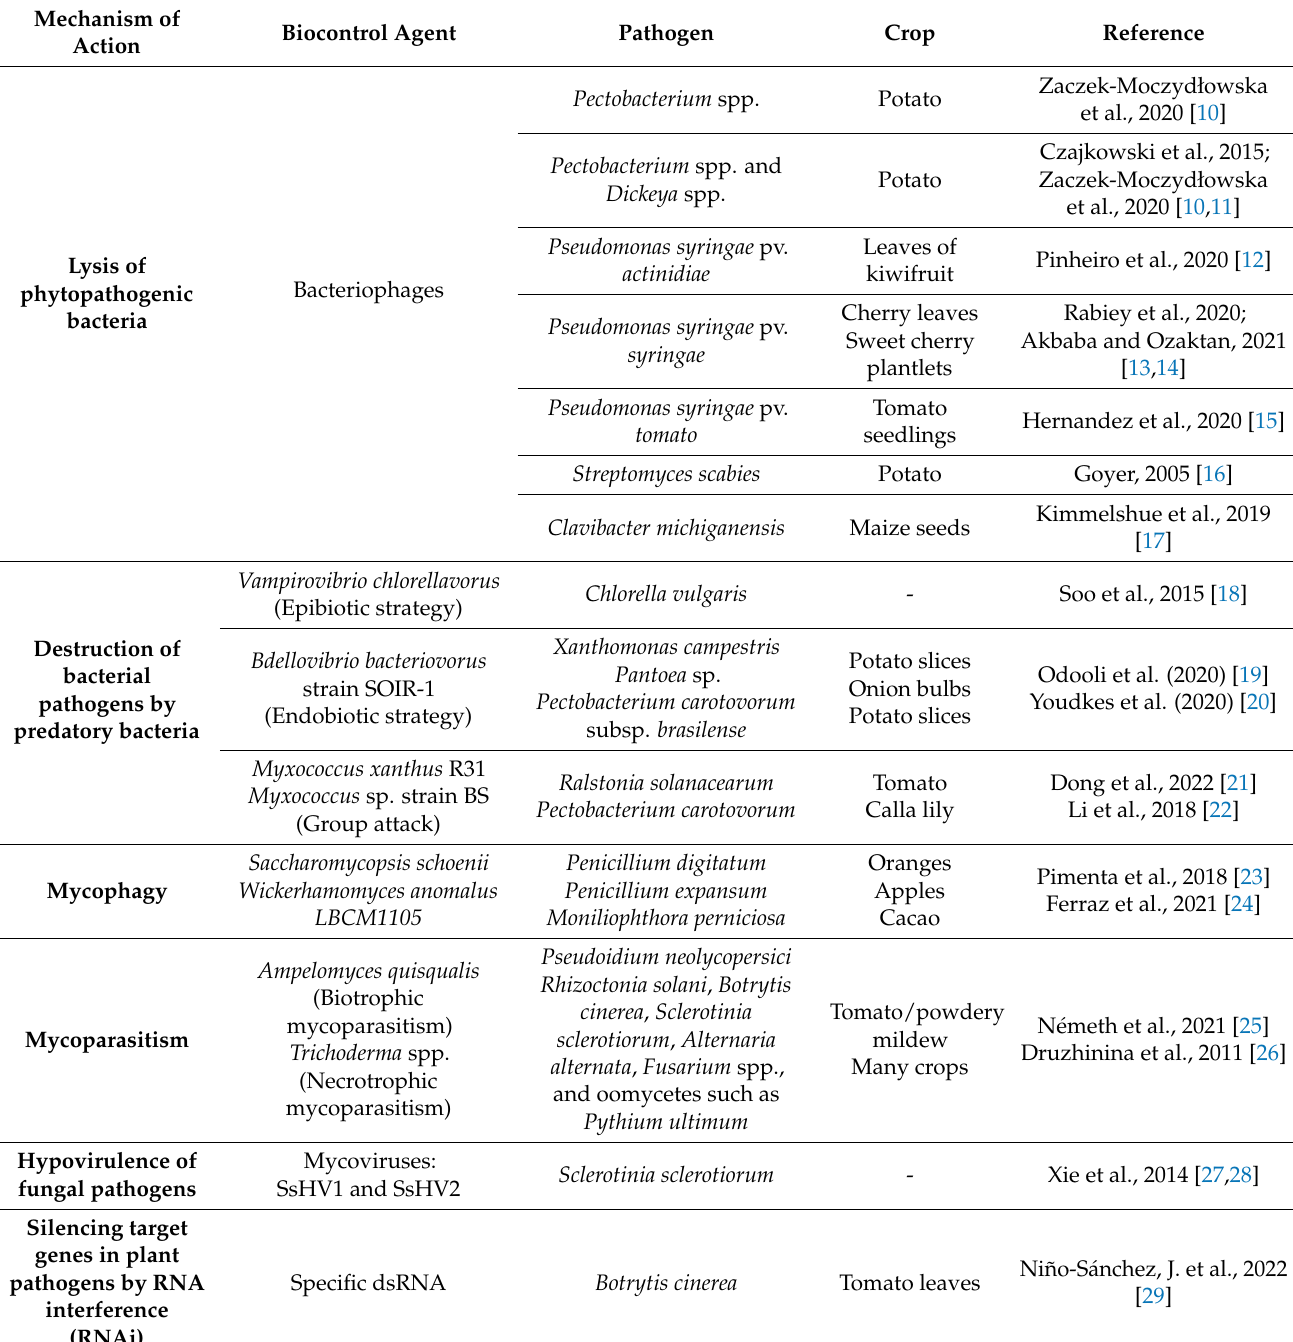
Table 1. Modes of action that involve direct interaction and physical contact between the biological control agent and pathogen on different